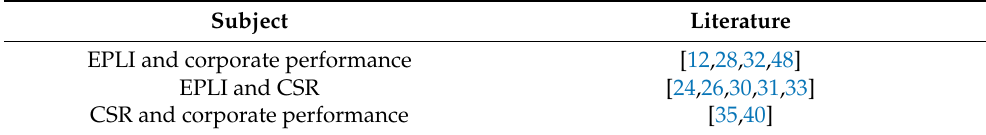
Table 1. Research route-related